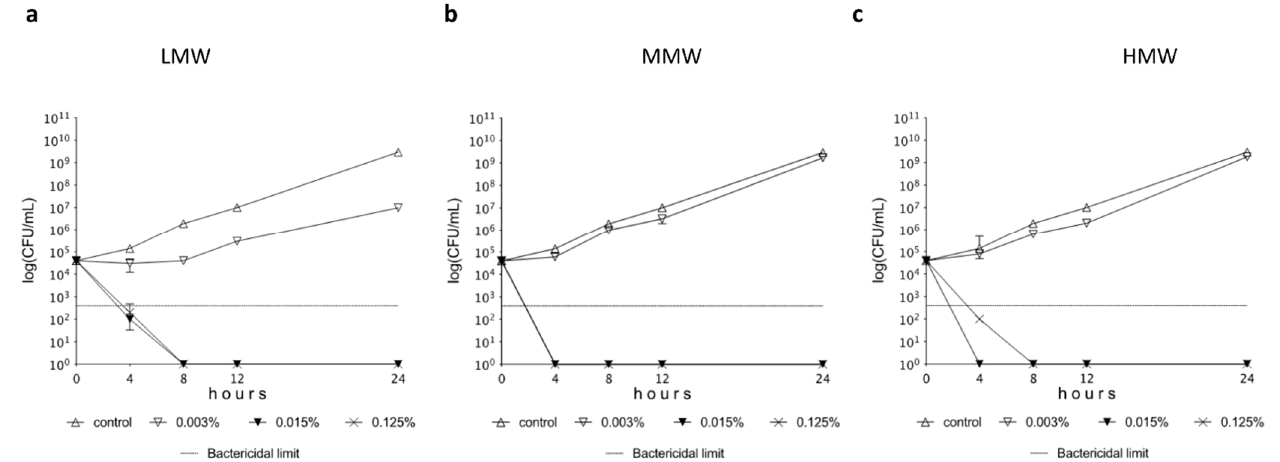
Figure 1. Time-kill plots of L. plantarum following exposure to 0.003–0.125% LMW ( a ), MMW ( b ), and HMW ( c ) chitosan solution in BHI medium. The investigation was done in triplicates.